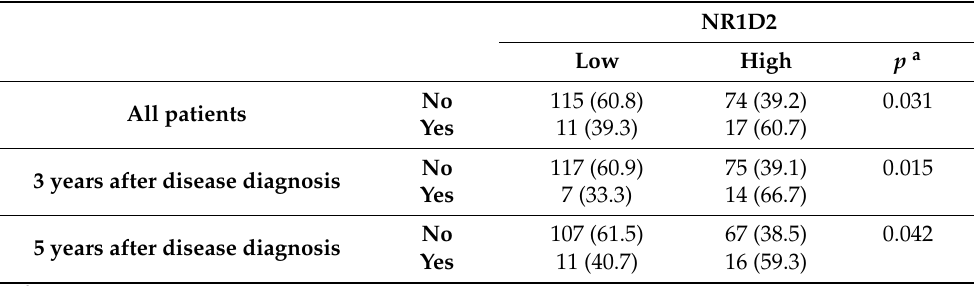
disease diagnosis of patients included in the study.